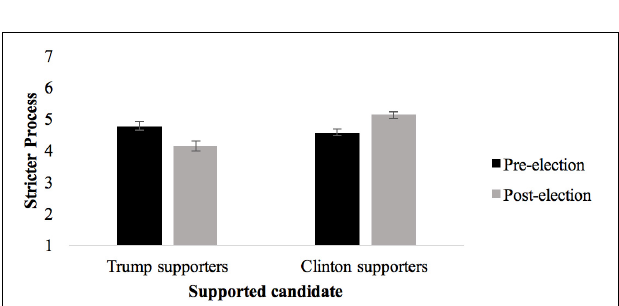
FIGURE 2 | Trump and Clinton supporters’ Acceptance of Stricter Election Before and After 2016 US Presidential Election (means and standard errors).